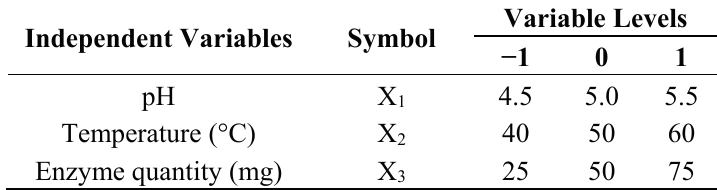
Table 6. Independent variables and their levels for Box-Behnken design of hydrolysis